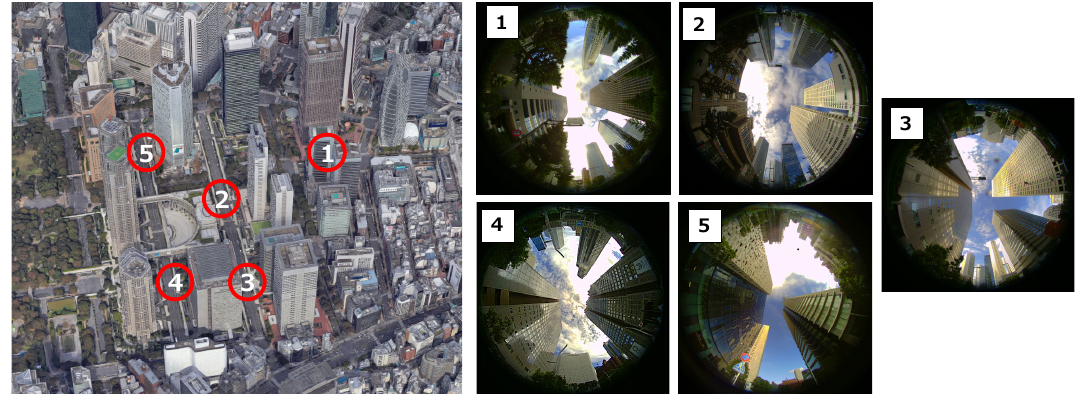
Figure 9. Experimental environment and sky images. We collected GNSS signal correlation outputs in five different locations in the